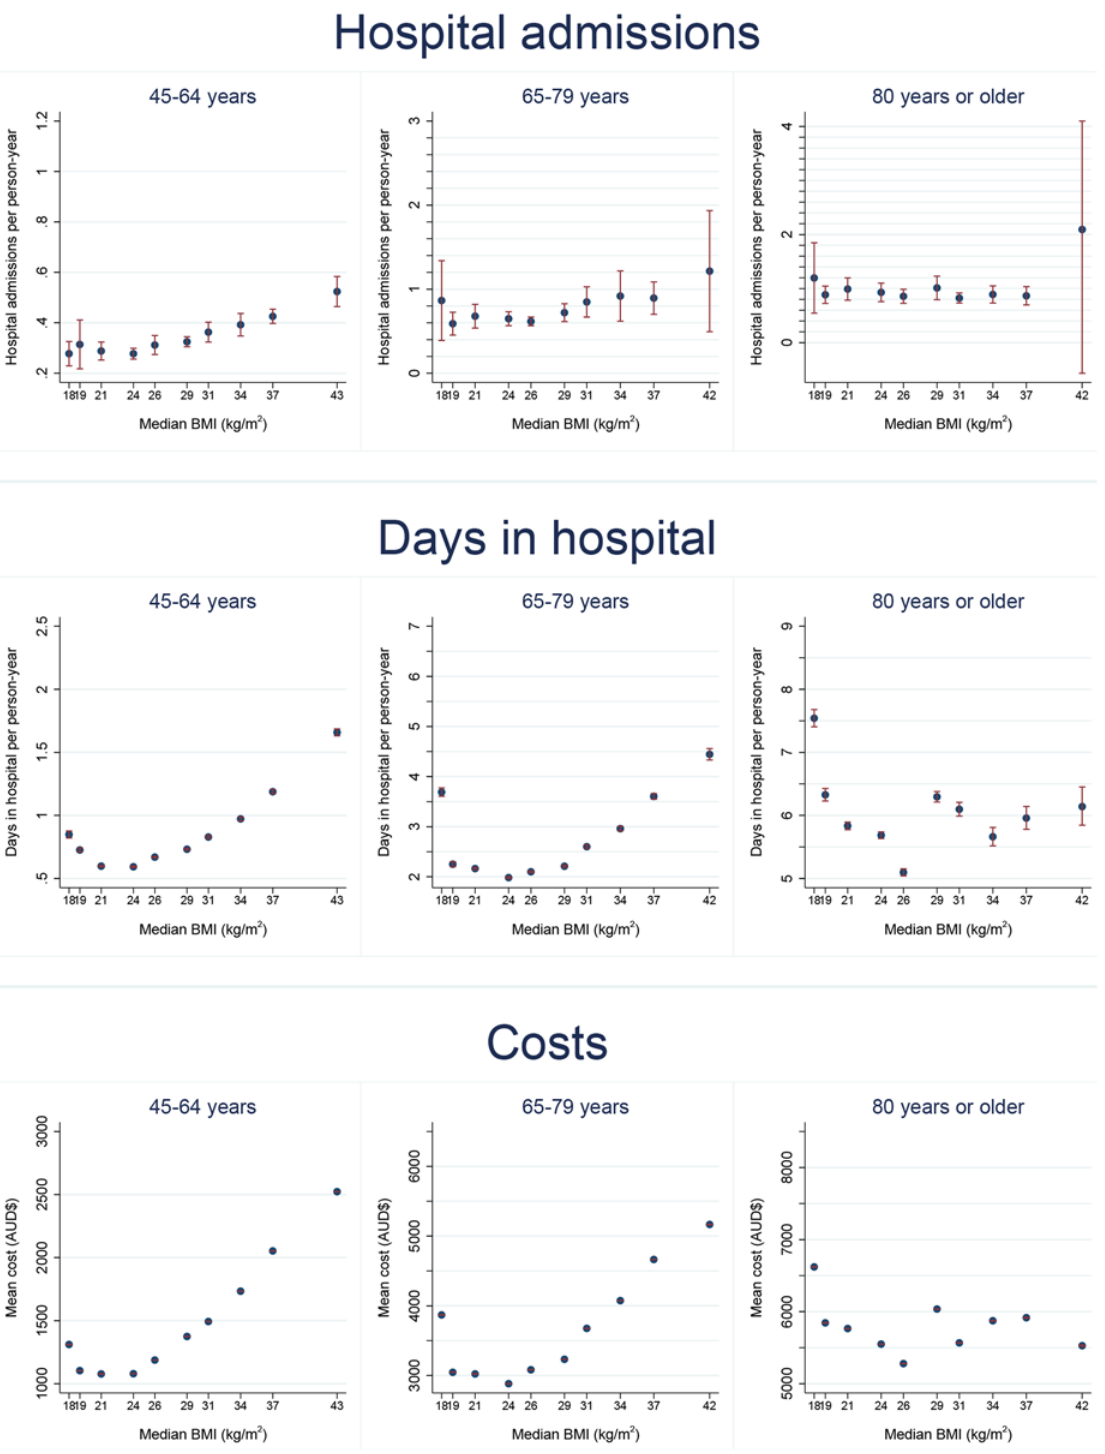
Fig 2. Age-standardised hospital admissions, days in hospital and costs per person-year (with 95% CIs) by body mass index (BMI), females. Notes. 1. Within each age group, rates are age-standardised to the 2006 NSW population (in 5 year age-groups) using the direct method. 2. The upper confidence interval for the 80 years or older age group for hospital admissions has been truncated to 4.1 (actual value is 4.8).